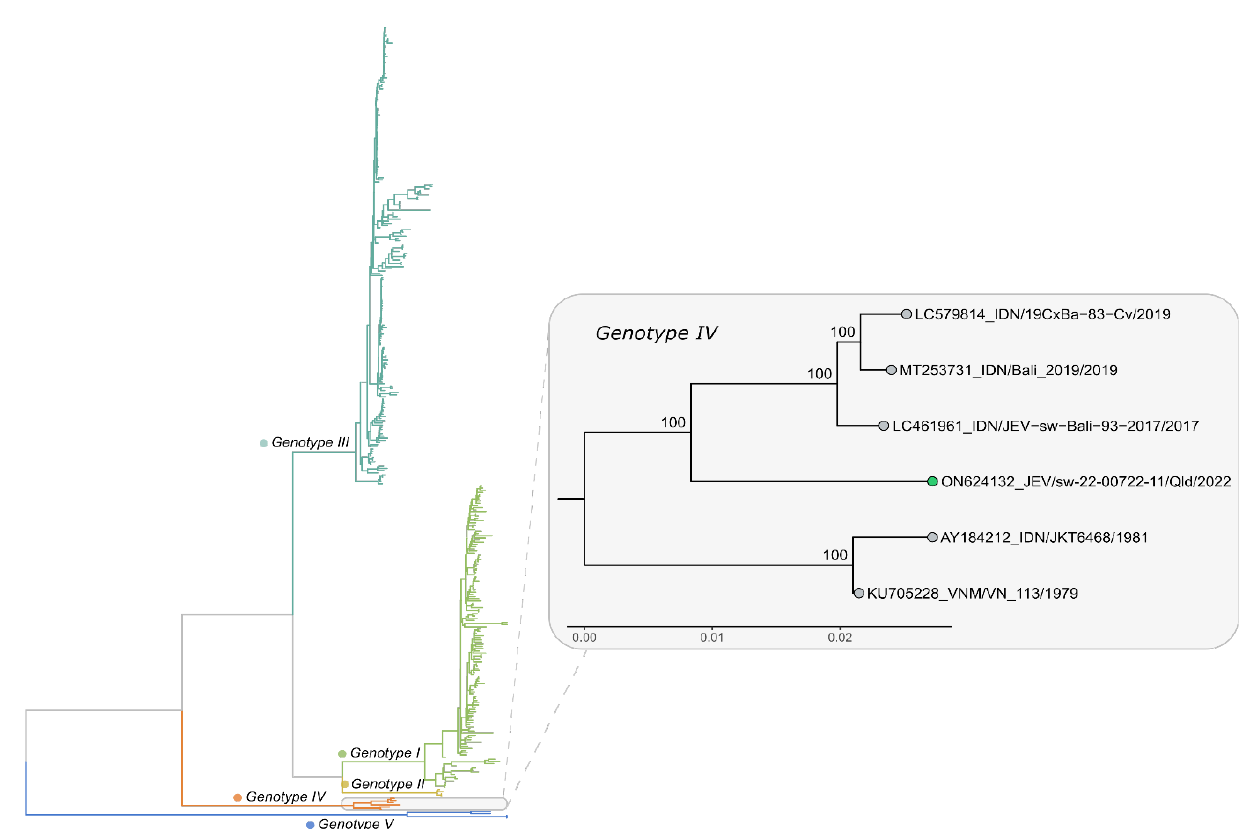
Figure 4. Phylogenetic tree showing the first JEV genome sequenced from an aborted fetus from a Queensland piggery in 2022 (green circle, inset) and its relationship to other available genotype IV whole genome sequences available from GenBank. The broader phylogenetic relationships of genotype IV with other JEV genotypes can be seen in the larger tree. The phylogenetic tree was estimated using the maximum likelihood method and a TN model with gamma rate heterogeneity, selected by IQ-TREE v.2.0.6. The results from 1000 bootstrap replicates are shown on the nodes and the scale represents the number of nucleotide substitutions per site.